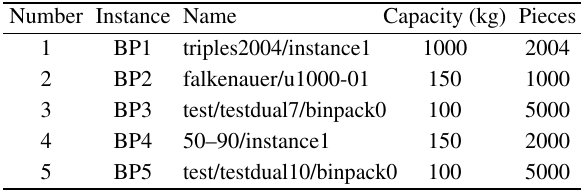
Table 3 One-dimensional bin packing